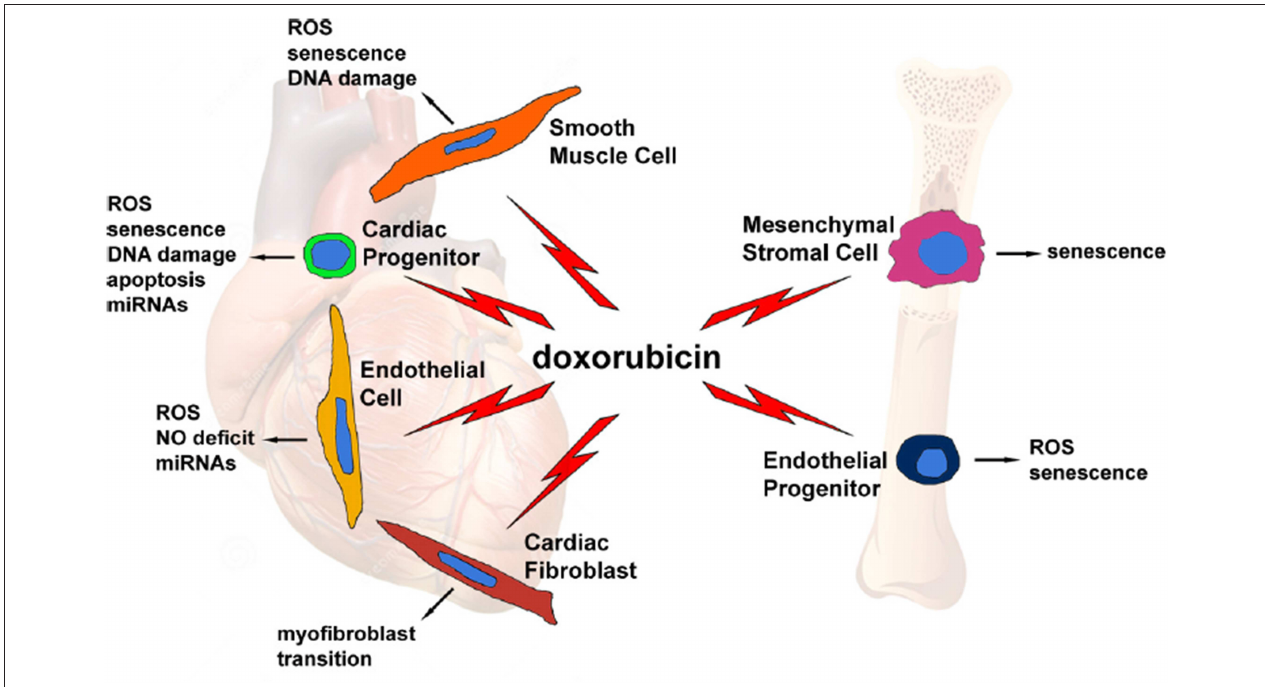
FIGURE 1 | Graphical representation of several doxorubicin-targeted cell types, with potential side effects and cellular and molecular events evoked by the drug. From Cappetta et al. ( 11).